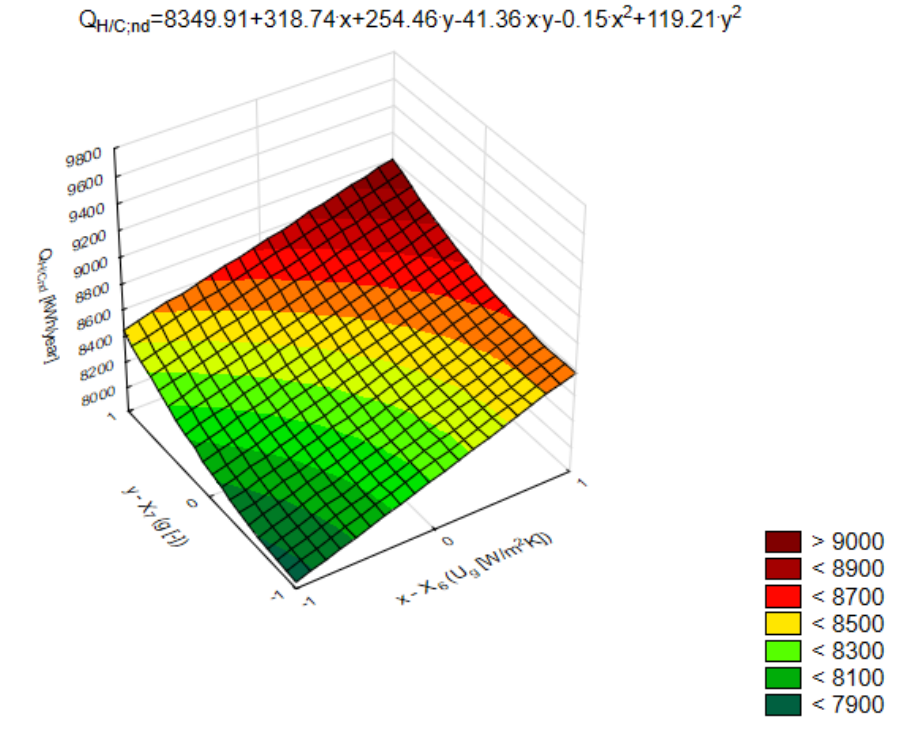
Figure 15 Figure 15. Dependence of Q H,Cnd on the factors from the third group of parameters, i.e., physical, regarding window solutions: X 6 —the heat transfer coefficient of the glazing U g and X 7 —the total transmittance of solar radiation energy of the glazing g